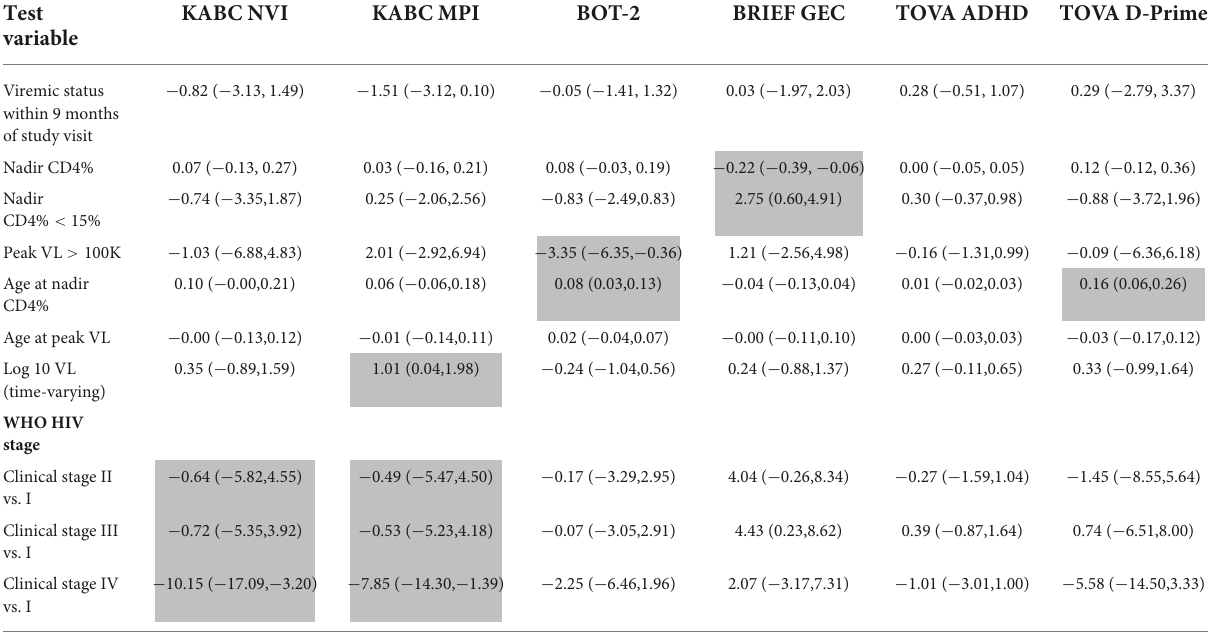
TABLE 4 HIV disease severity and factors associated with neuropsychological